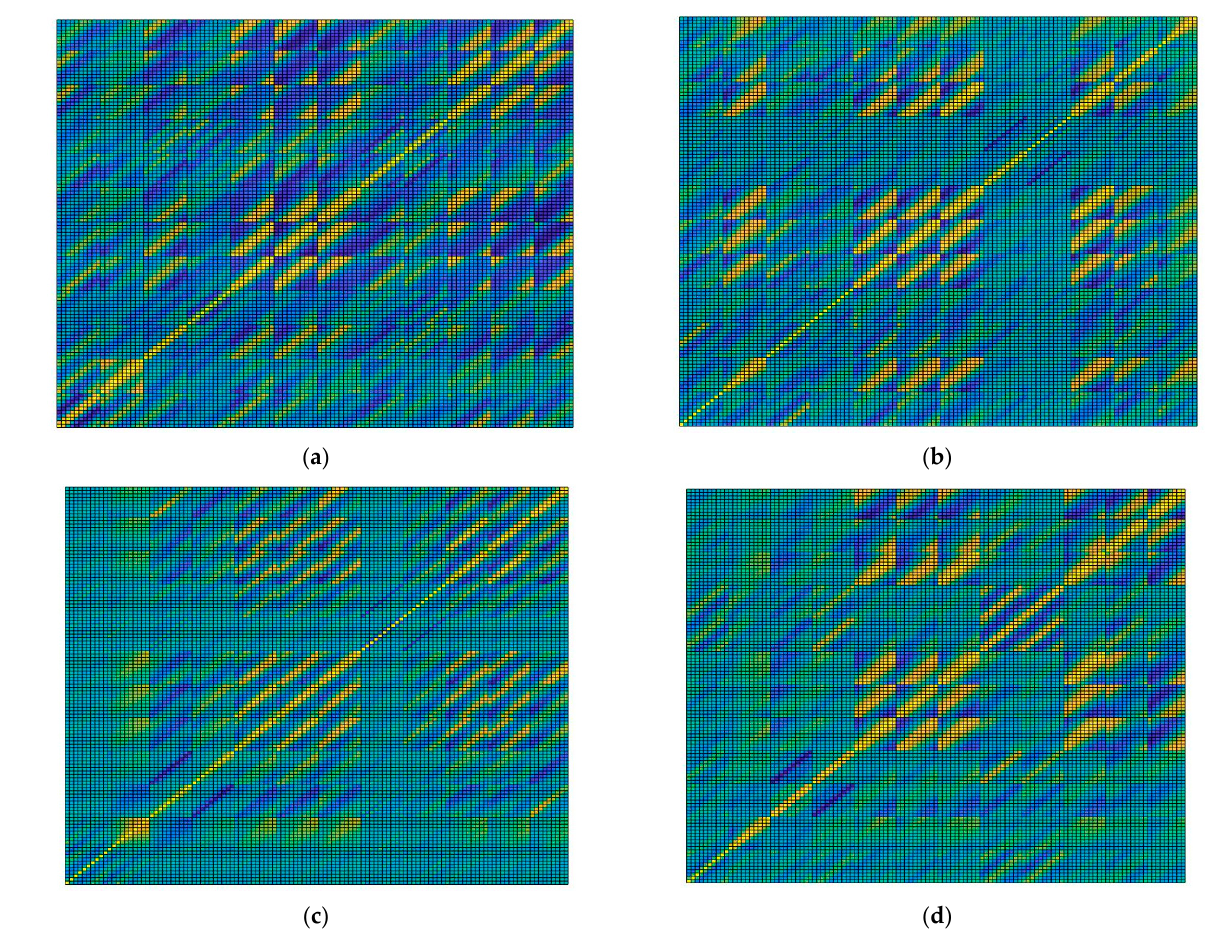
Figure 24. The surface plot of a correlation coefficient matrix split in 12 × 12 sections corresponding to the monitored signal pairs, with a 10 × 10 section providing the quantification of interdependency on shifted versions of the corresponding signals. For illustration, the surface plot of the correlation coefficient matrix computed for the healthy control and the three PD patients from Figure 13 is illustrated in Figure 25. Inter- pretation of the correlation coefficient matrices follows in Section 4—Discussion.